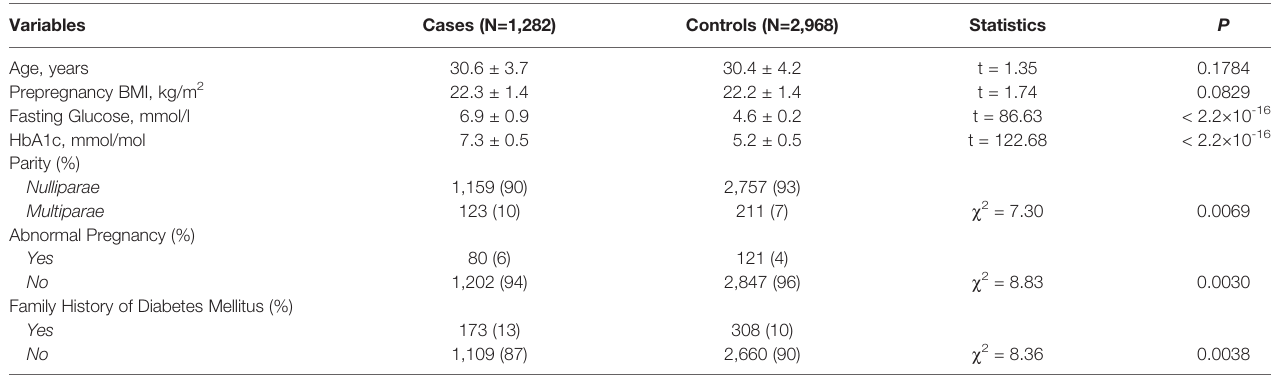
TABLE 1 | Demographic and clinical characteristics of the study